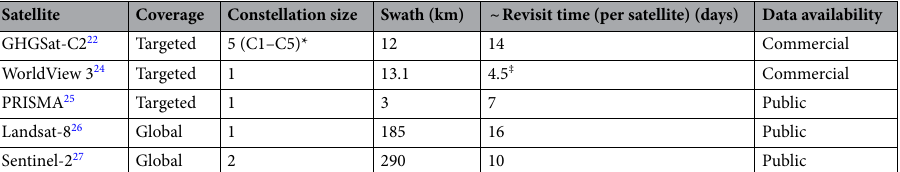
Table 1. Key characteristics of each participating satellite constellation, from lowest to highest swath width, which is roughly proportional to an instrument’s minimum methane detection limit. Global coverage refers to a configuration that passively covers most of Earth’s surface over some number of orbits, while targeted coverage refers to a “point-and-shoot” instrument that must be pointed to a particular location. *GHGSat-C3– C5 were launched after the conclusion of testing. ‡ For best resolution within 20° off nadir. WorldView 3 has 1-day revisit time at lower guaranteed